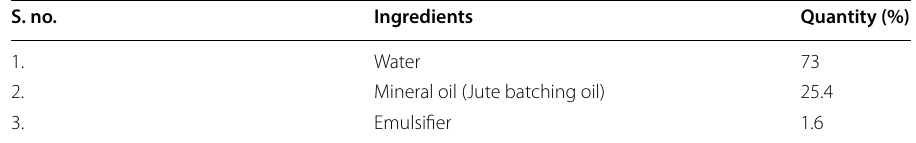
Table 3 Emulsification concentrations S.